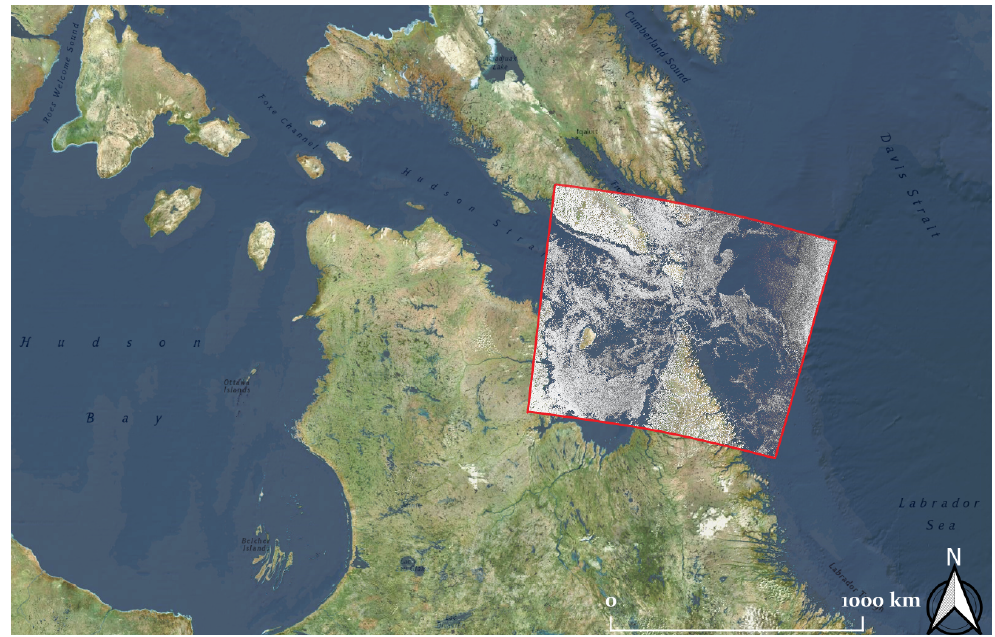
Figure 1. The geographical area of interest of captured SAR scenes. Red polygon represents the geographic extent of a SAR image used in the study. Table 1. Description of RADARSAT-2 scenes dataset that was used to train, validate, and test various model